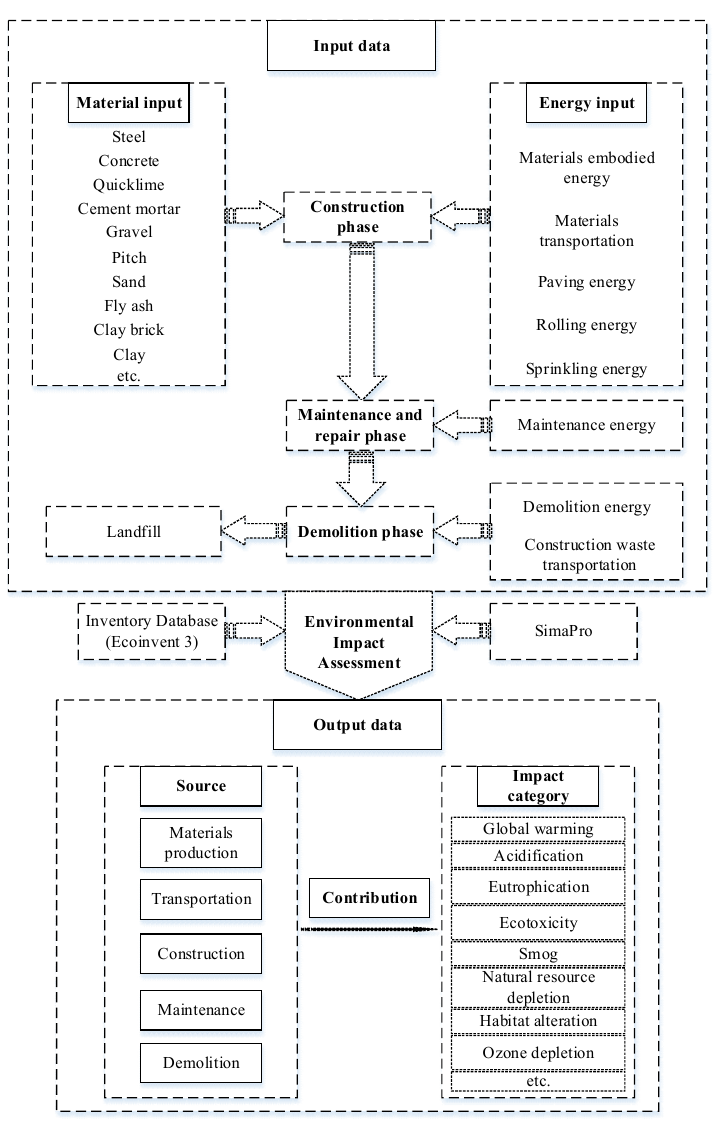
Figure 2. The development EIA model.